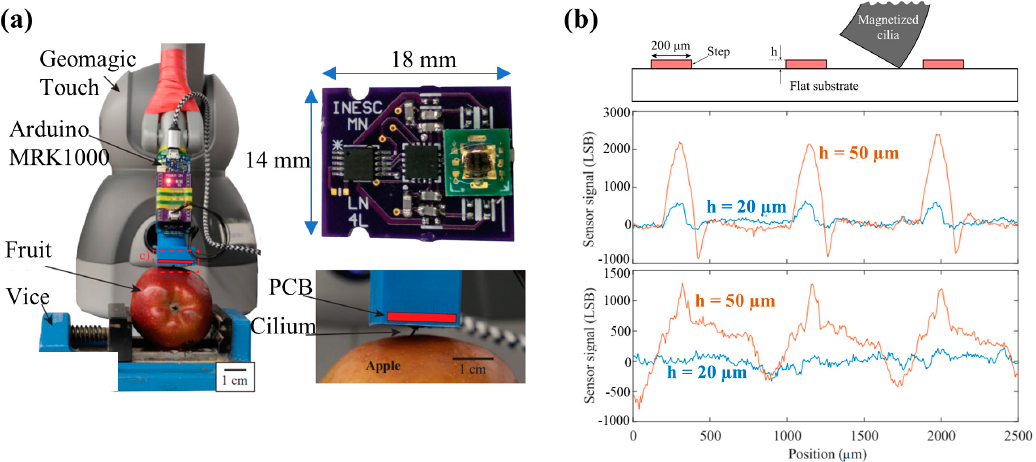
Figure 16. ( a ) Photograph of the tactile sensor with 9 cilia (designed by Pedro Ribeiro) and the test scenario when it is used to distinguish the rotten state of fruits. Reprinted with permission from Ref. [71]. Copyright 2020, IEEE; ( b ) Test diagram of texture characterization and the test results of 1 × 3 (top) and 3 × 3 (bottom) cilia array. Reprinted with permission from Ref. [120]. Copyright 2020, IEEE.